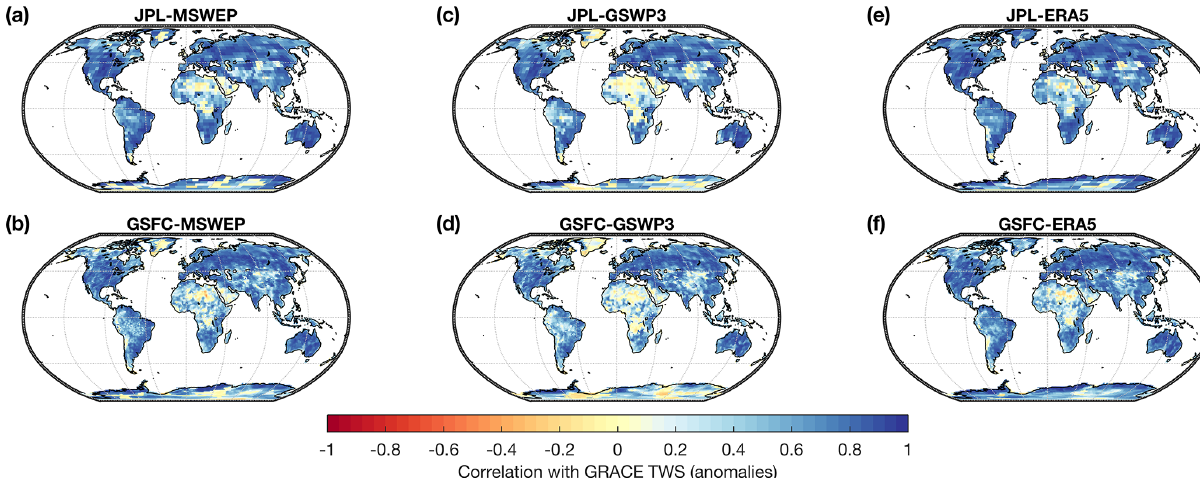
Figure 5. Correlation (of de-seasonalized, de-trended anomalies) between GRACE-REC and GRACE JPL mascons (a, c, e) or GRACE GSFC mascons (b, d, f) . Three different precipitation forcing datasets are tested: MSWEP (a, b) , GSWP3 (c, d) , and ERA5 (e, f) . Values closer to 1 correspond to a higher model performance.